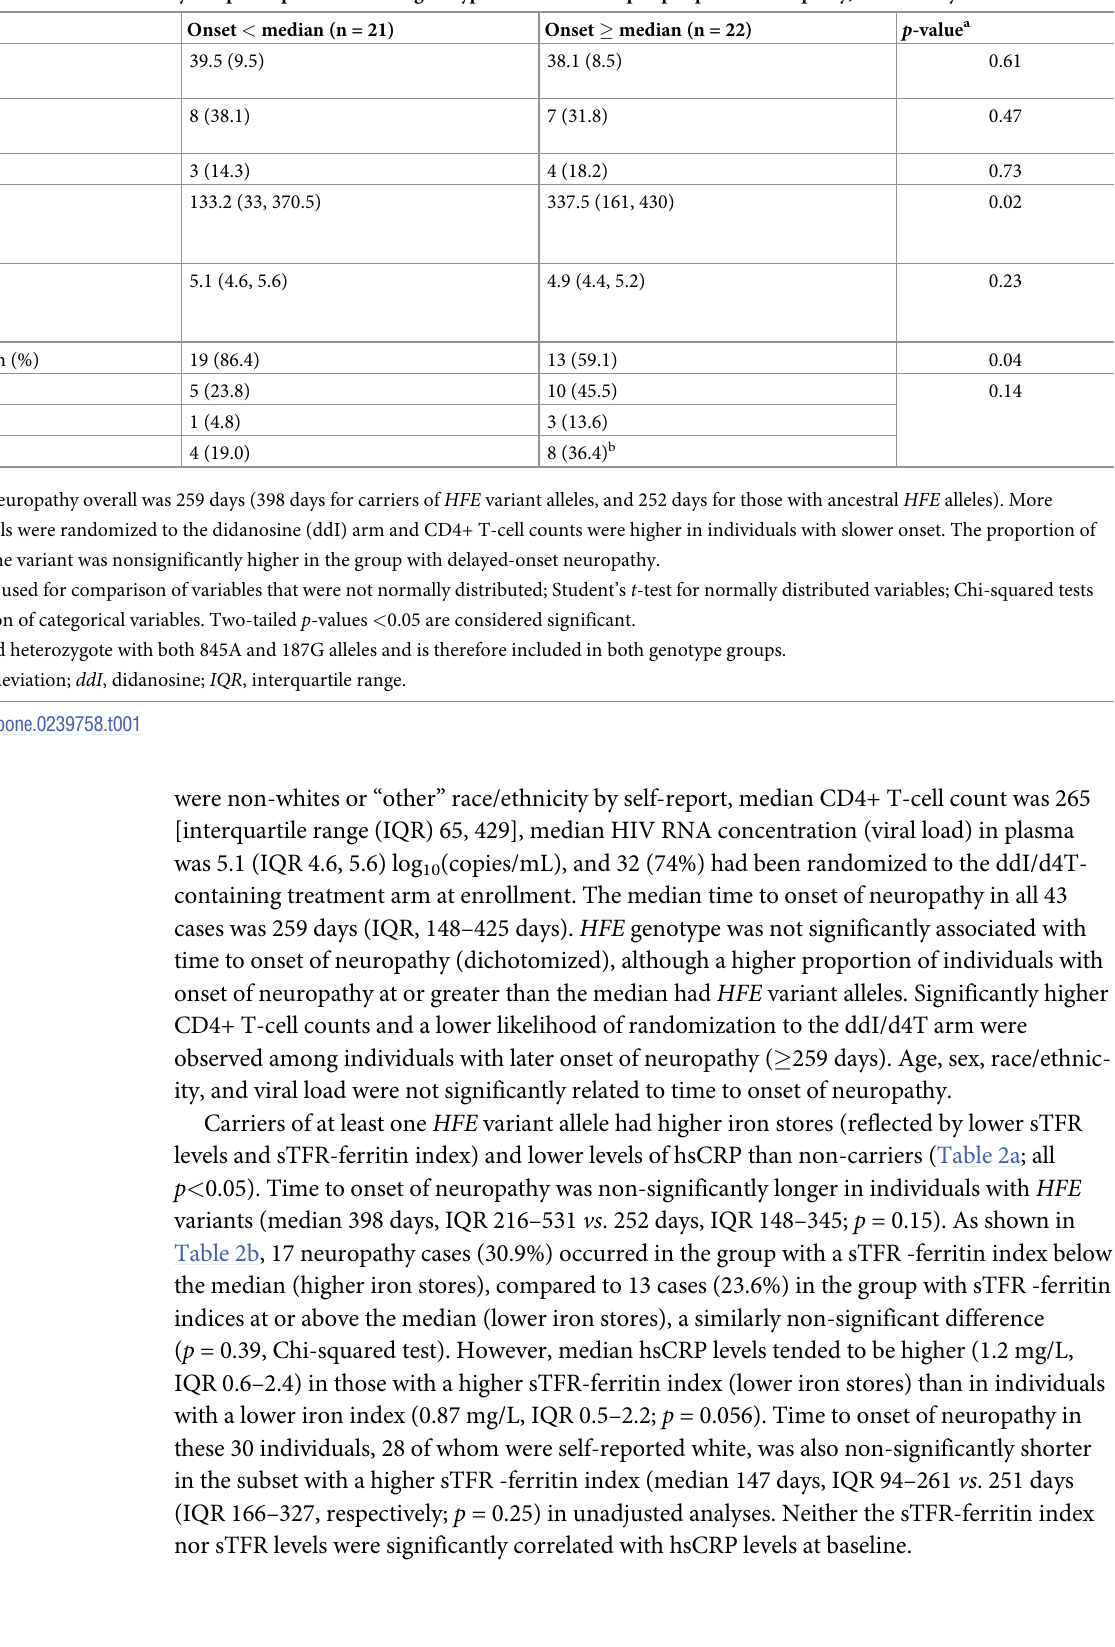
Table 1. Baseline characteristics of 43 ACTG Study 384 participants with HFE genotype data who developed peripheral neuropathy, stratified by time to onset. Onset < median (n = 21)